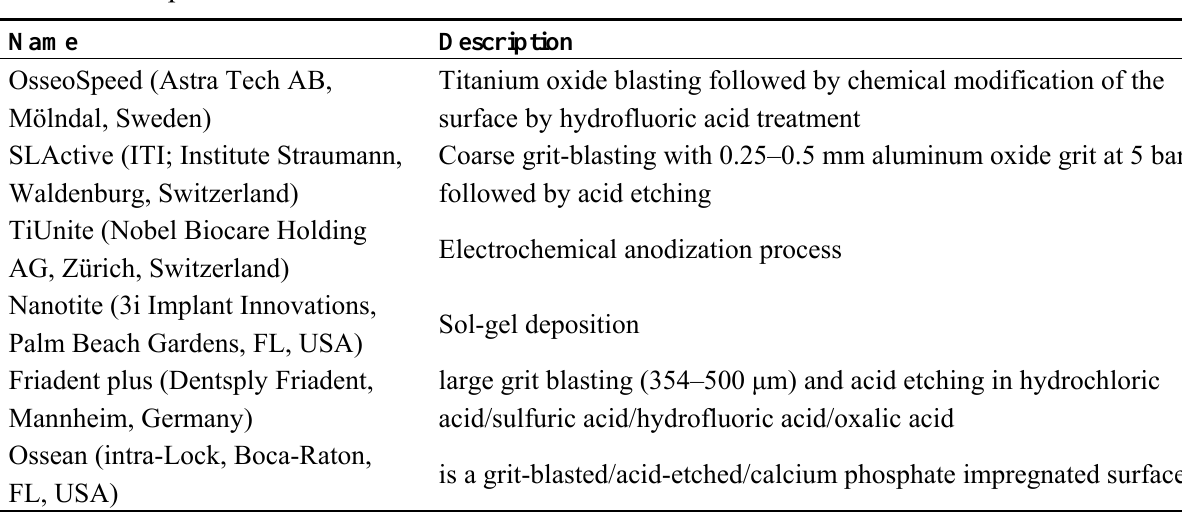
Table 1. Overview of commercially available surface modifications (topography) for dental